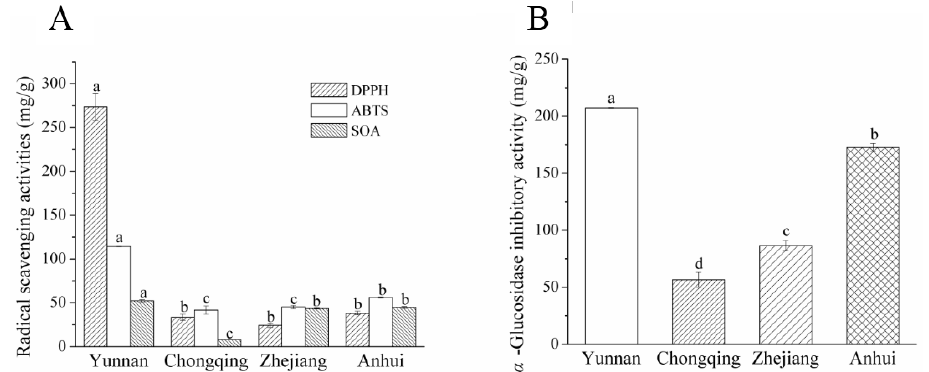
Figure 3. ( A ) DPPH, ABTS and SOA radical-scavenging activities and ( B ) α-glucosidase inhibitory activity of the dried fruits of C. speciosa. Results are shown as mean ± SD ( n = 3). Different letters above each bar indicate significant differences ( p < 0.05). DPPH, 2,2-diphenyl-1-picrylhy-drazyl; ABTS, 2,2’-azino-bis(3-ethylbenzothiazoline-6-sulfonic acid); SOA, super oxygen anion.